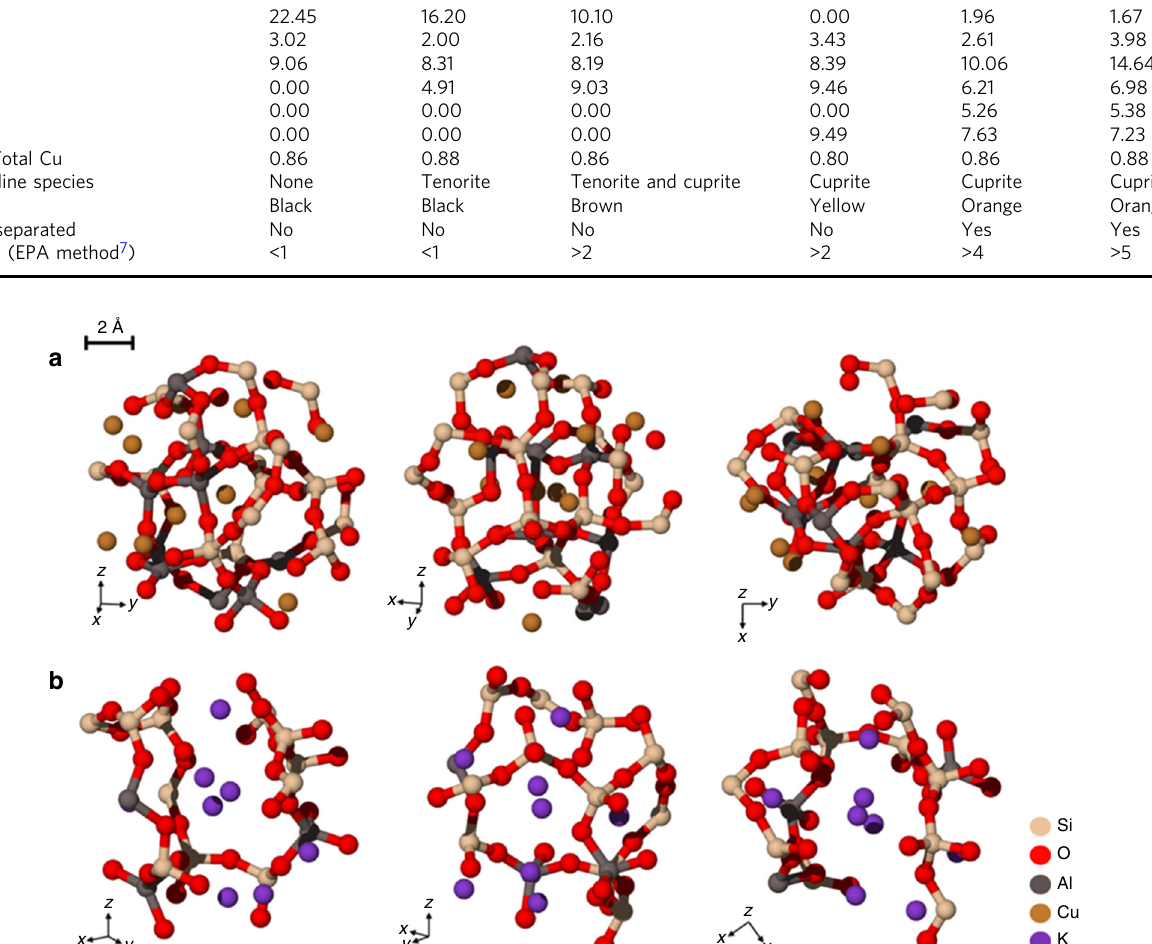
Fig. 1 Structures of two model glass compositions by molecular dynamics simulations a Model glass with composition of 60SiO 2 − 20Al 2 O 3 − 20Cu 2 O (in mol%). The model shows a tightly packed glass network structure surrounding small, high- fi eld strength copper (I) ions. b Model glass with composition